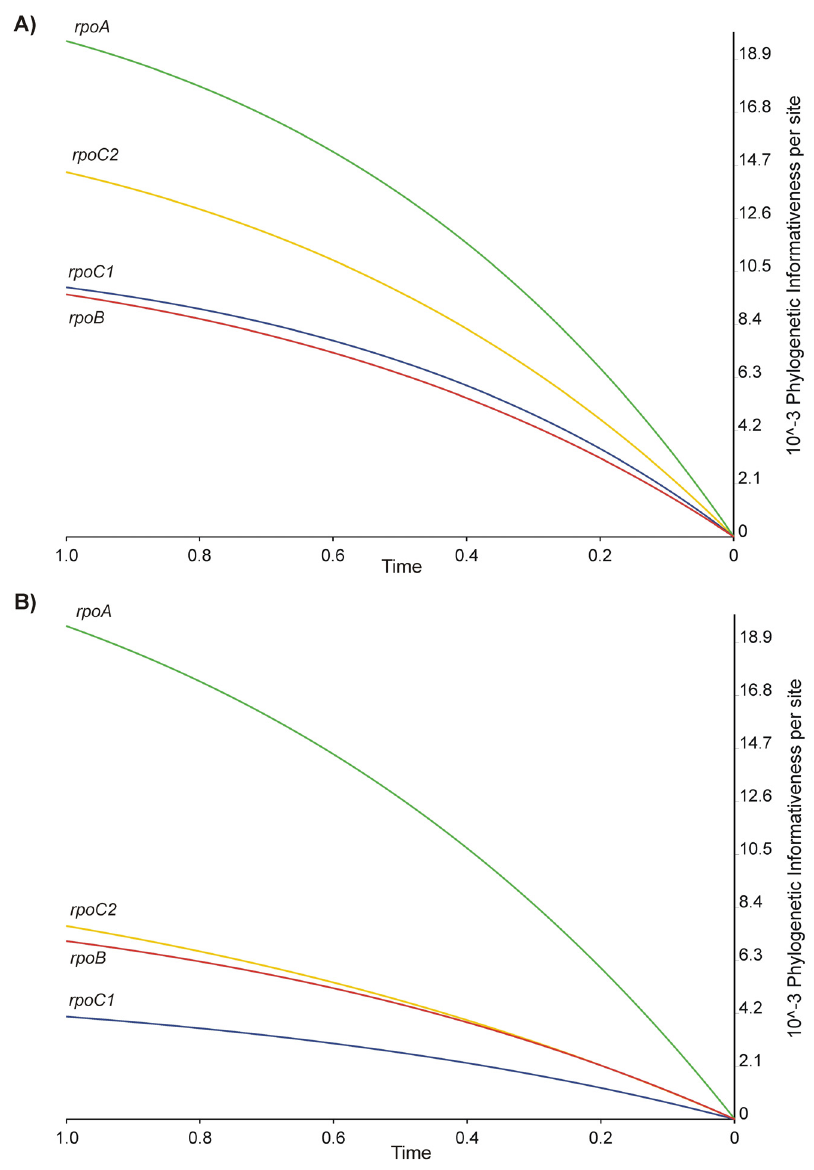
Figure 4. Profile of phylogenetic informativeness for rpo genes per site calculated from ( A ) the nucleotide and ( B ) the amino acids sequences ( rpoA — green, rpoB — red, rpoC1 — blue, rpoC2 — yellow). The time axis is calibrated in relation to the ultrametrisized ML tree derived from the dataset of four rpo genes. An evolutionary time of 1.0 corresponds to the root of the tree and the value of 0 to its